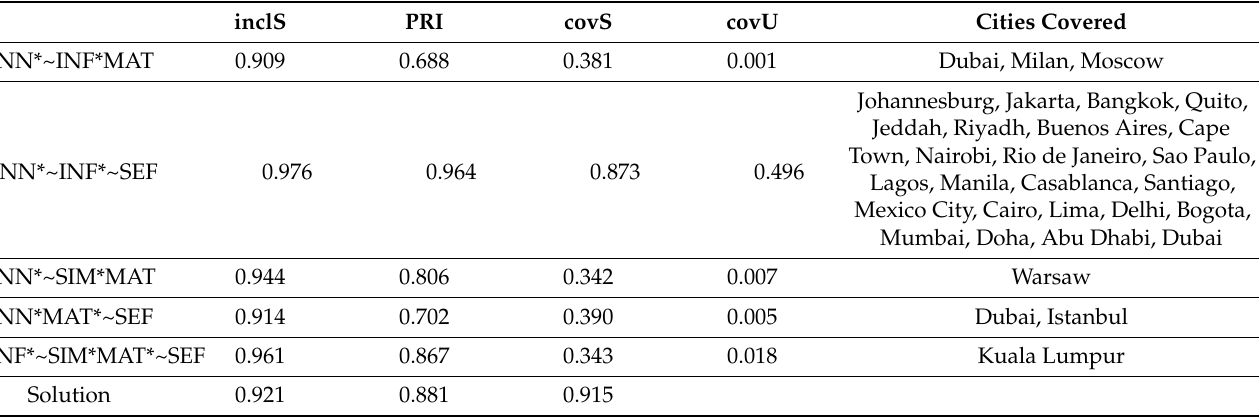
Table 4. Enhanced intermediate solution for